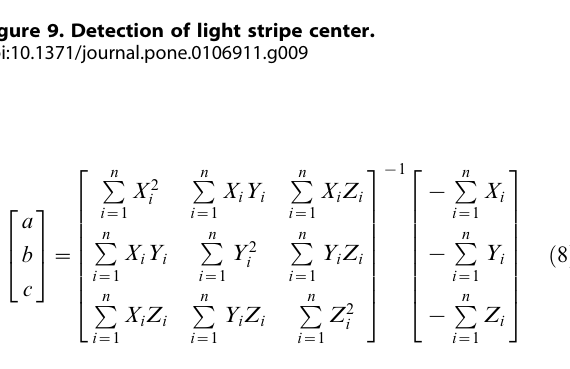
Based on the intrinsic parameters and the light plane coefficients, the world coordinates of intersection points of the light plane with the world object surface can be solved.